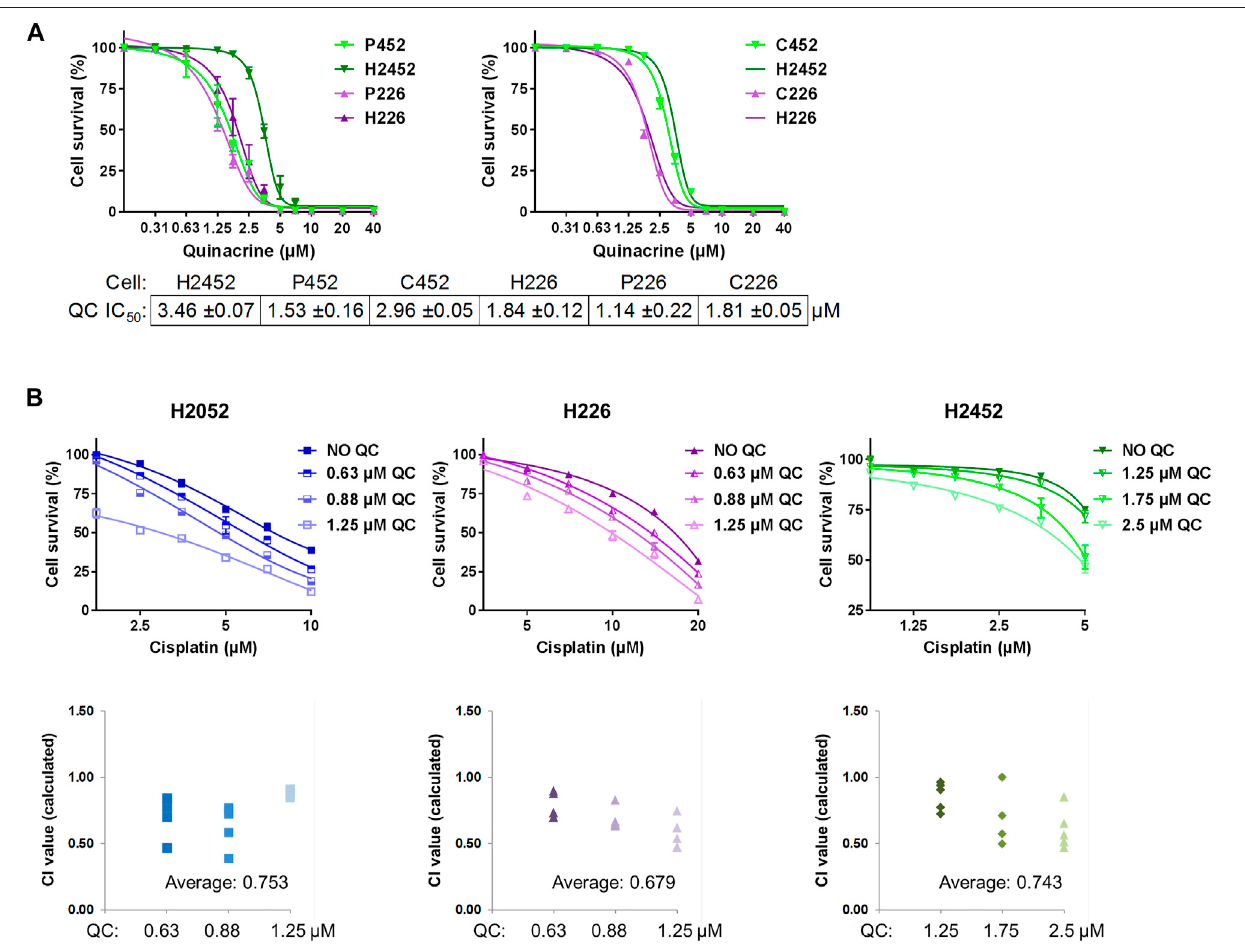
FIGURE 1 | Quinacrine response compared with isogenic drug resistant cells and in combination with cisplatin. (A) Cell death assays using quinacrine in pemetrexed resistant (P452, P226) and cisplatin resistant (C452, C226) cells compared to isogenic controls (H2452 and H226). All 6 cell lines were assessed in parallel and curves for H2452 and H226 are shown in both graphs (the second time omitting error bars). (B) Cell death assays using cisplatin with different concentrations of quinacrine. Combination index values ( bottom ) were calculated for each combination. Values below 1.00 are considered synergistic.